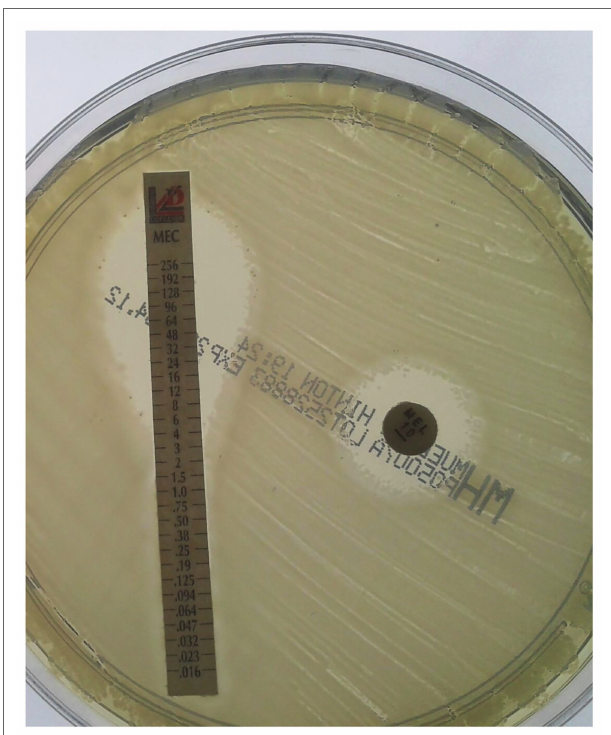
FIGURE 1 | Susceptibility testing of mecillinam by agar diffusion methods in an isolate of K. pneumoniae producing NDM. Agar gradient diffusion and disk diffusion of the isolate with an inhibition zone diameter of 12 mm (resistant) and an MIC of 8 mg/L (susceptible) by gradient test, compared to 64 mg/L (resistant) by the reference